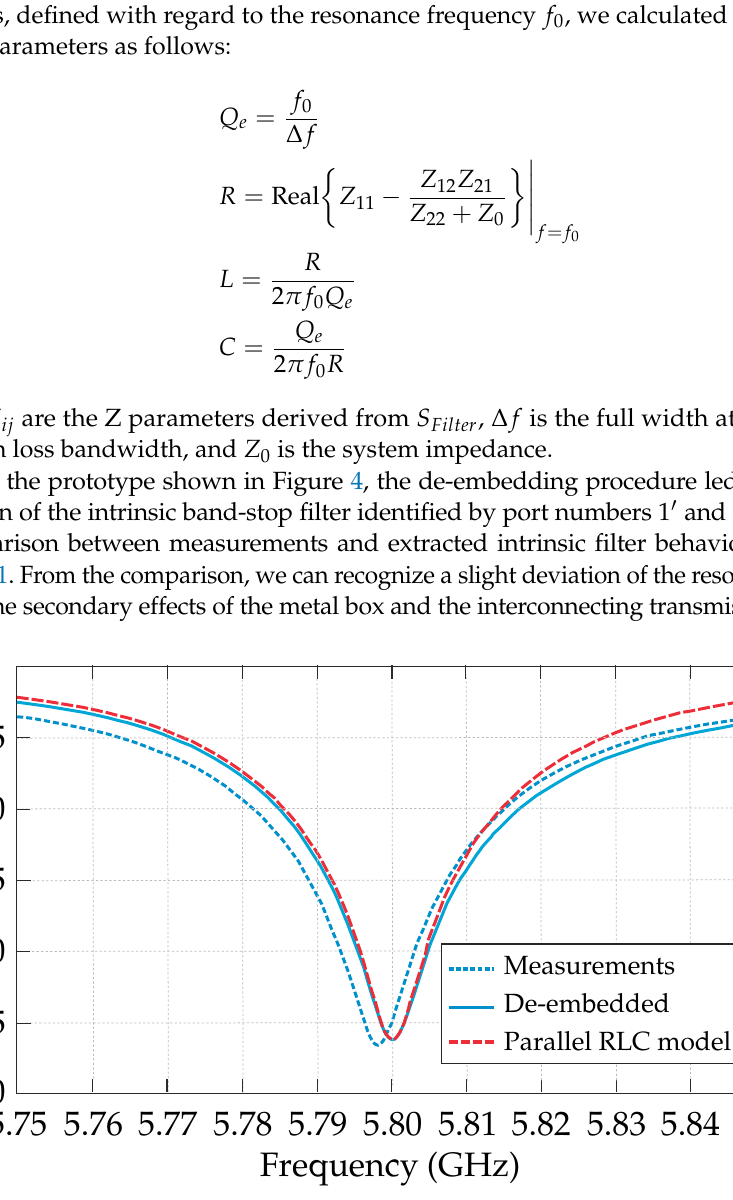
Figure 11. Comparison of mag ( S 21 ) of de-embedded data, measurements, and simulation with the RLC circuit model of Figure 8 for V r = 7